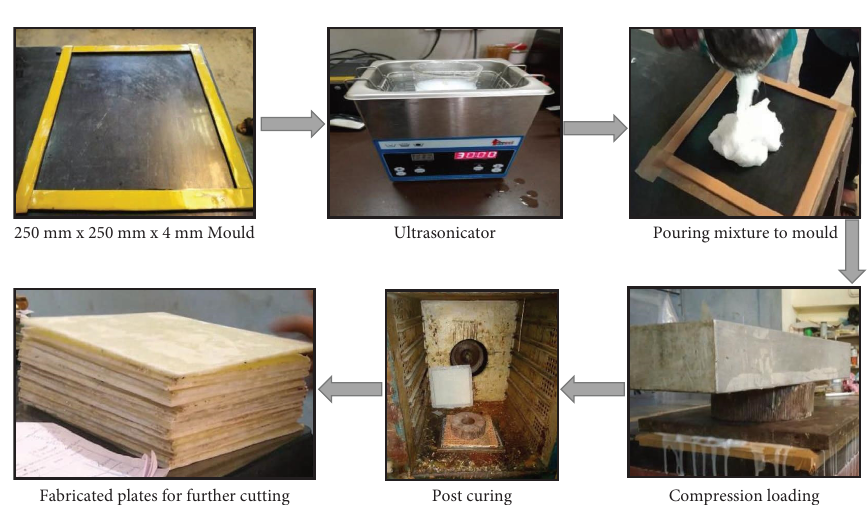
2 O 3 nanofller.